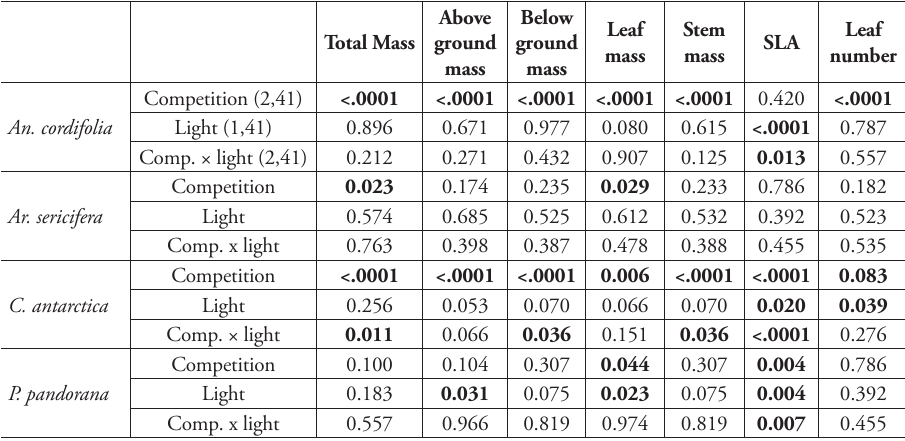
Above Below Leaf Stem Leaf Total Mass ground ground SLA mass mass mass mass